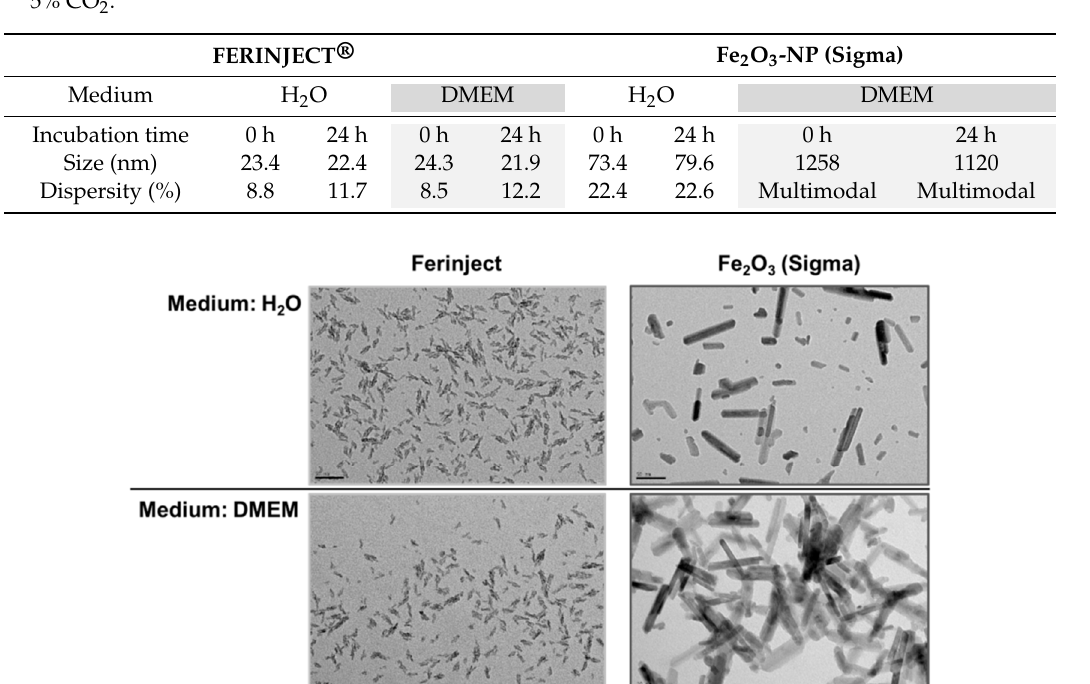
Table 1. Characterization of FERINJECT ® and Fe 2 O 3 -NP Sigma by DLS. Nanoparticles were incubated in H 2 O or DMEM (with carboxymaltose coating for Fe 2 O 3 -NP Sigma) after 24 h of incubation at 37 °C, 5% CO 2 .